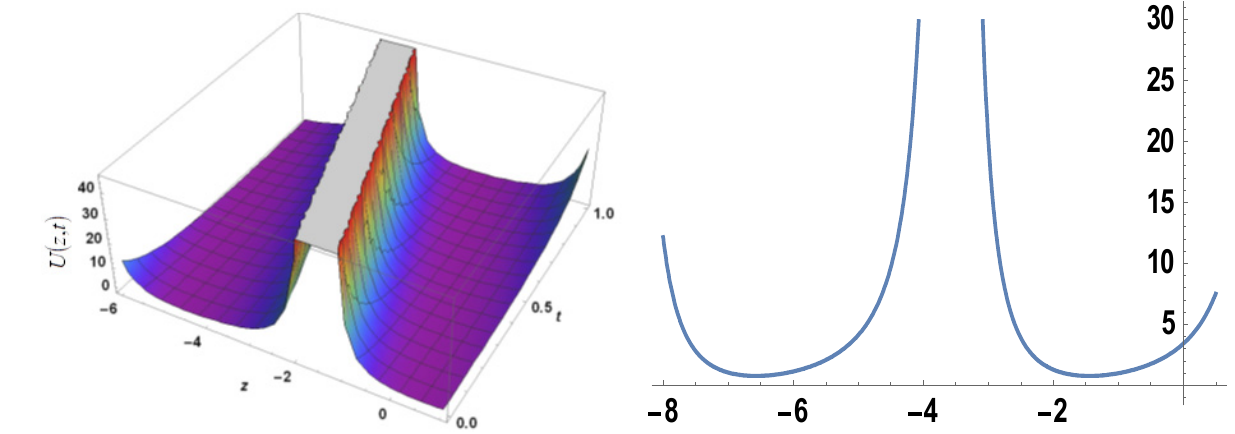
Figure 14. The 3D and 2D plots of Equation (64) for various values of parameters.